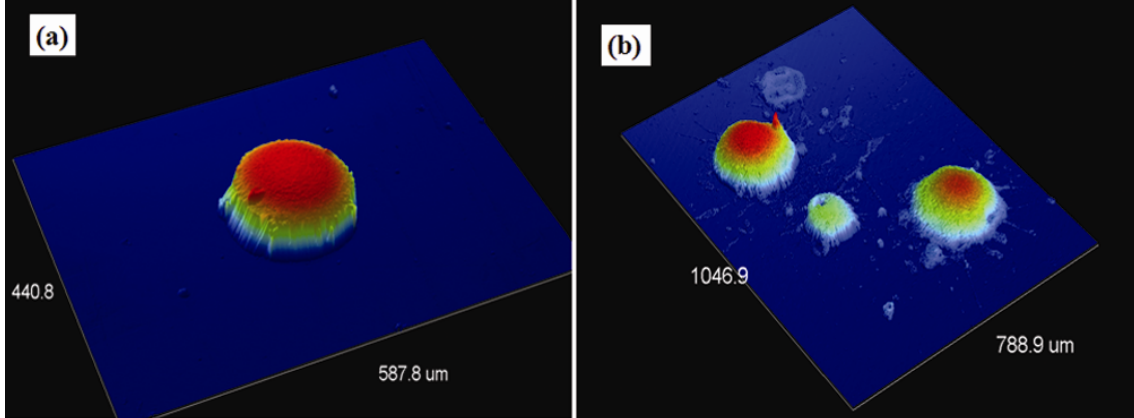
Figure 7. Single splats scanned by ContourGT surface profiler ( a ) disc splat and ( b ) splashed